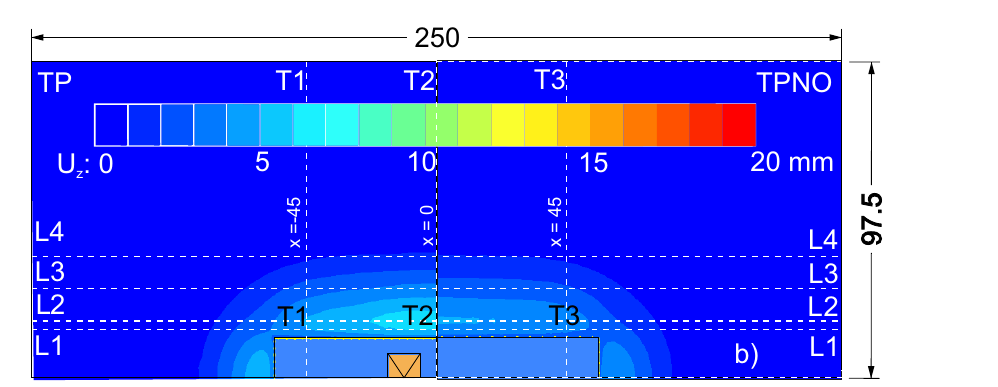
Figure 9. Settlement around the excavation, case TP and